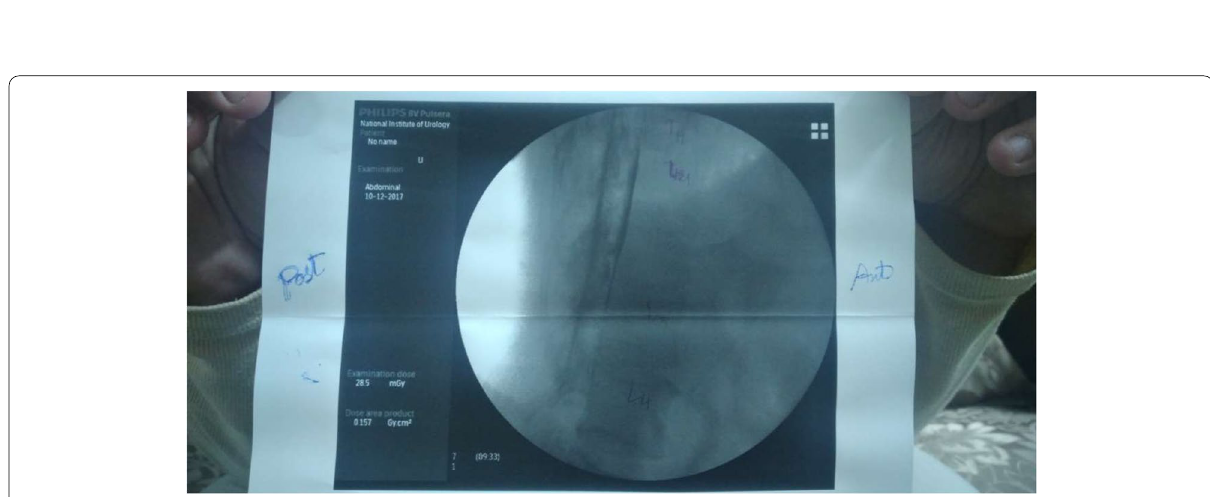
Fig. 2 A lateral image showing anterior and posterior columns of contrast, the dye spread to the anterior epidural